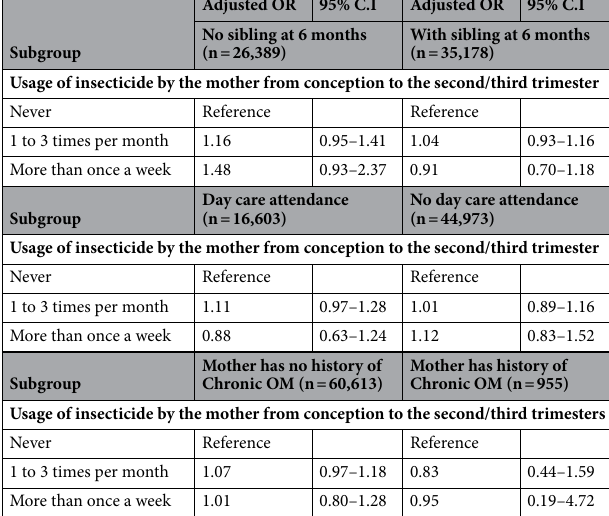
Adjusted OR 95% C.I Adjusted OR 95% Subgroup